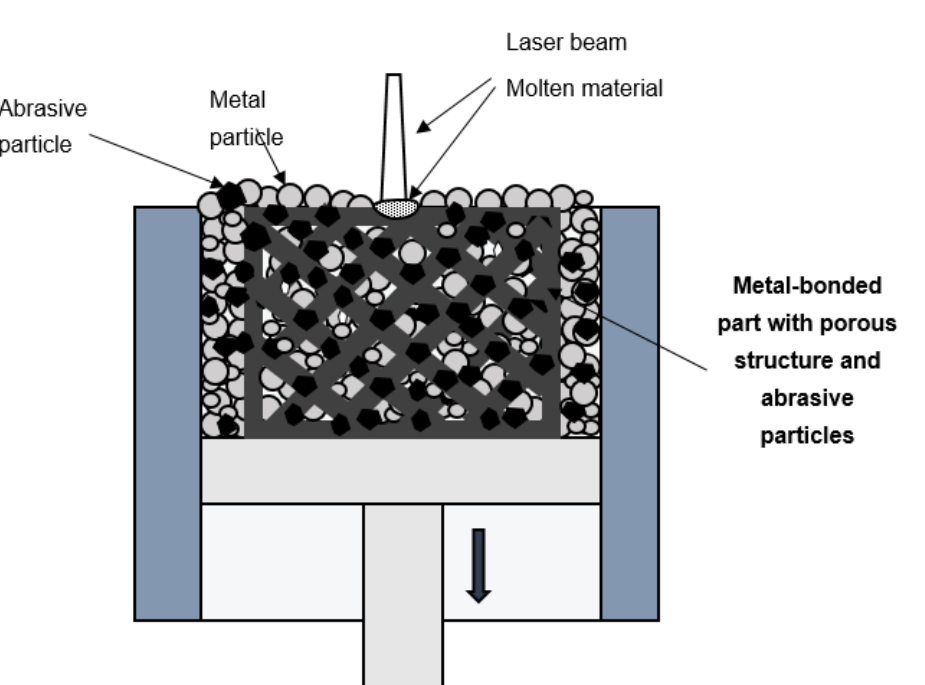
Figure 5. The principle of the SLM process for the fabrication of a grinding wheel with the structure of high porosity; based on references [91,92].